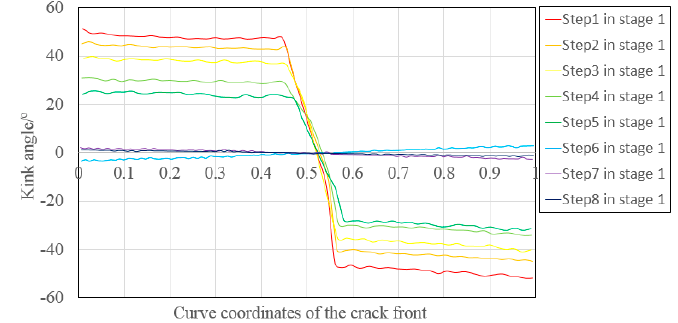
Figure 13. Evolution of kink angle ( K equ + SERR).